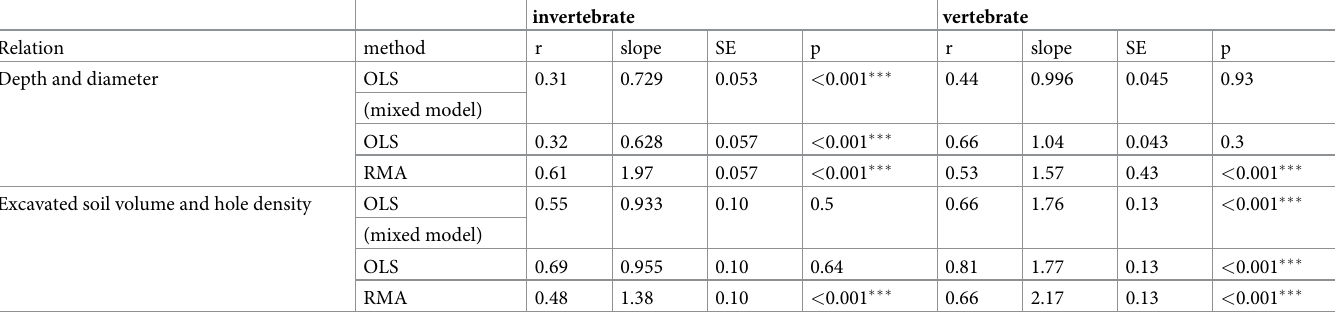
Table 2. Ordinary least squares (OLS) and reduced major axis (RMA) regression analyses of the relationships between the depth and mean diameter of the holes and between the excavated soil volume and hole density for invertebrates and vertebrates (all variables log 10 -transformed).